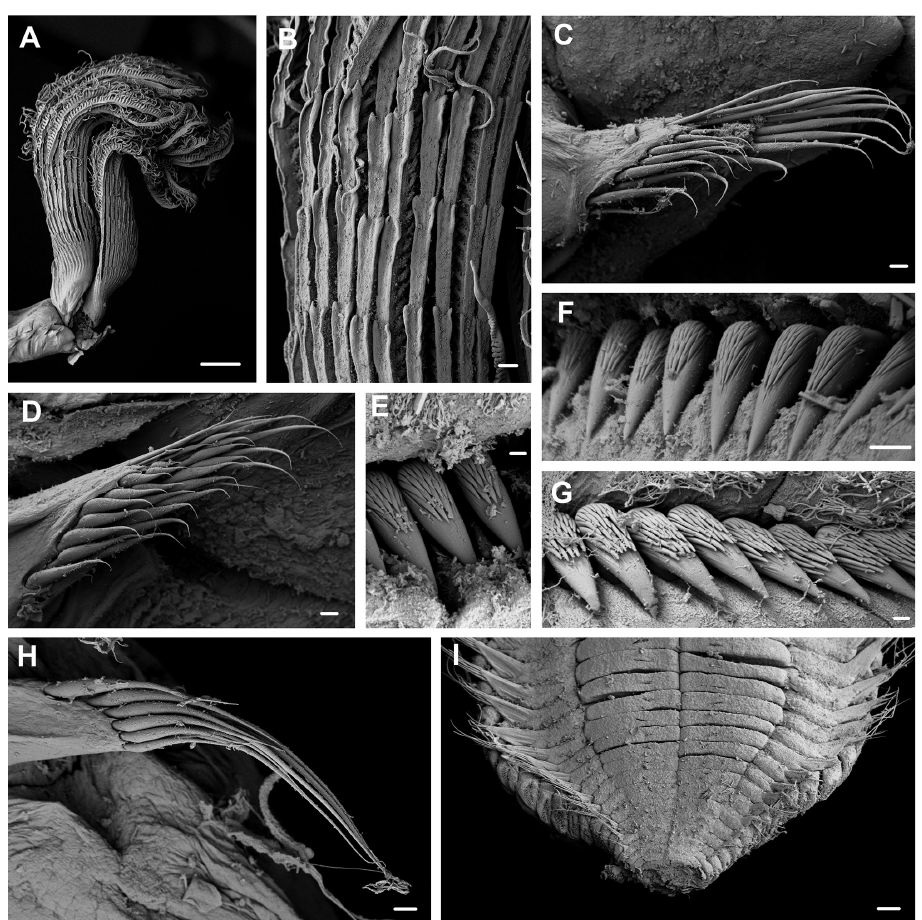
Figure 5. Pseudobranchiomma cf. P. orientalis AM W.37204: Scanning electron micrographs A Anterior end, lateroventral view B Detail of lateral flanges serrations C Notopodia, first thoracic segment D Noto- podia, fifth thoracic segment E Uncini, second thoracic segment F Uncini, fifth thoracic segment G Pos- terior abdominal uncini H Neuropodia, mid abdominal segment I Posterior end, ventral view. Scale bars: A = 1 mm; B, I = 100 µm; C, D, G, H = 20 µm; E = 3 µm; F = 10